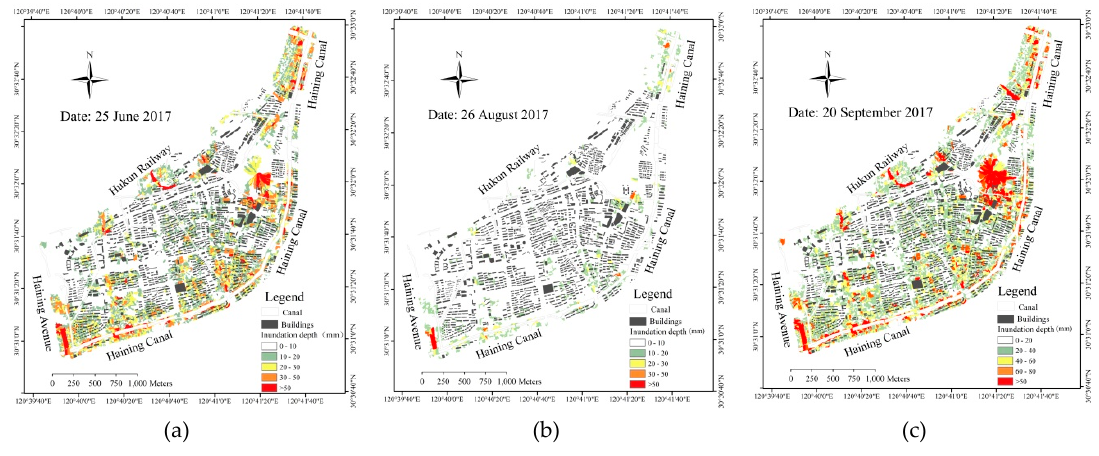
Figure 8. Simulated inundation results. ( a ) 25 June 2017; ( b ) 26 August 2017; ( c ) 20 September 2017.